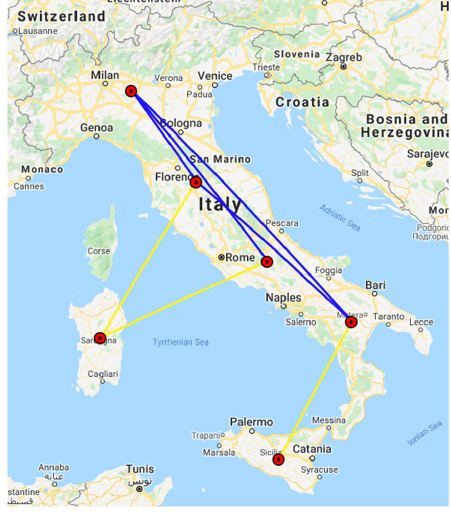
Figure 16. Optimal transmission grid layout for flex and non-flex cases.